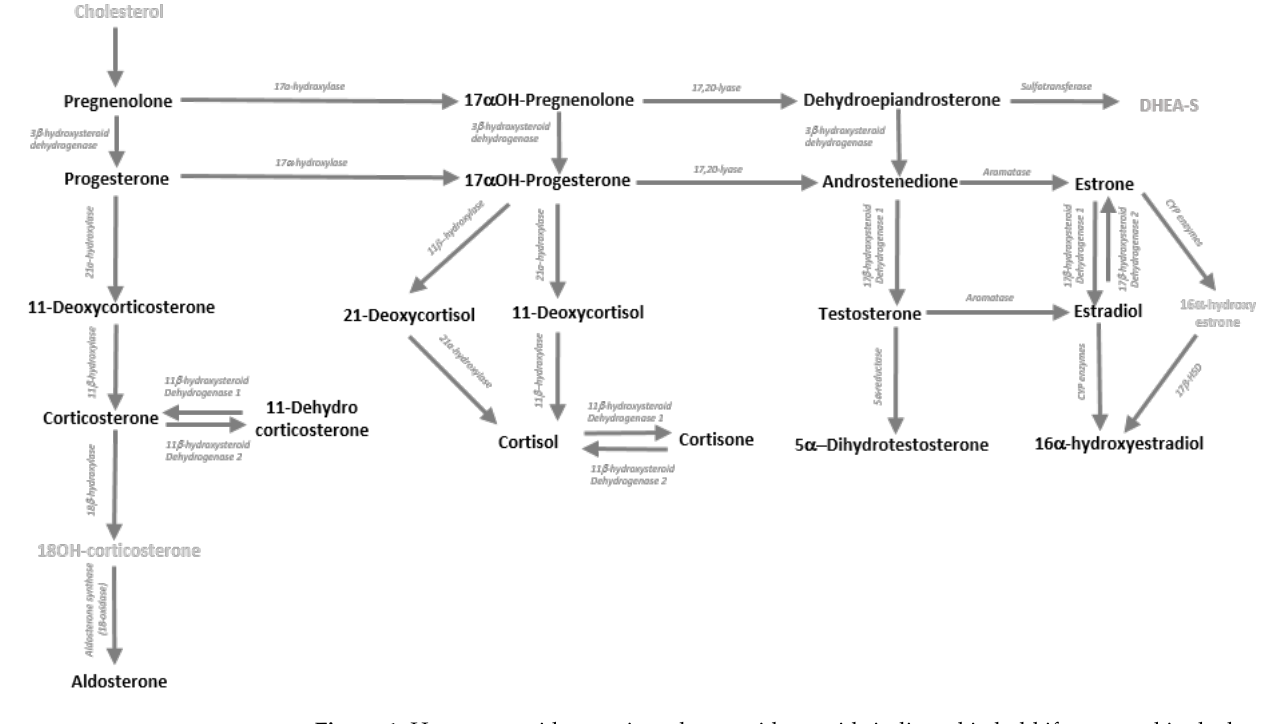
Figure 1. Human steroidogenesis pathway with steroids indicated in bold if measured in the human saliva samples by LC-MS/MS. Relevant enzymes indicated above the arrows. HSD is hydroxyster- oid dehydrogenase.